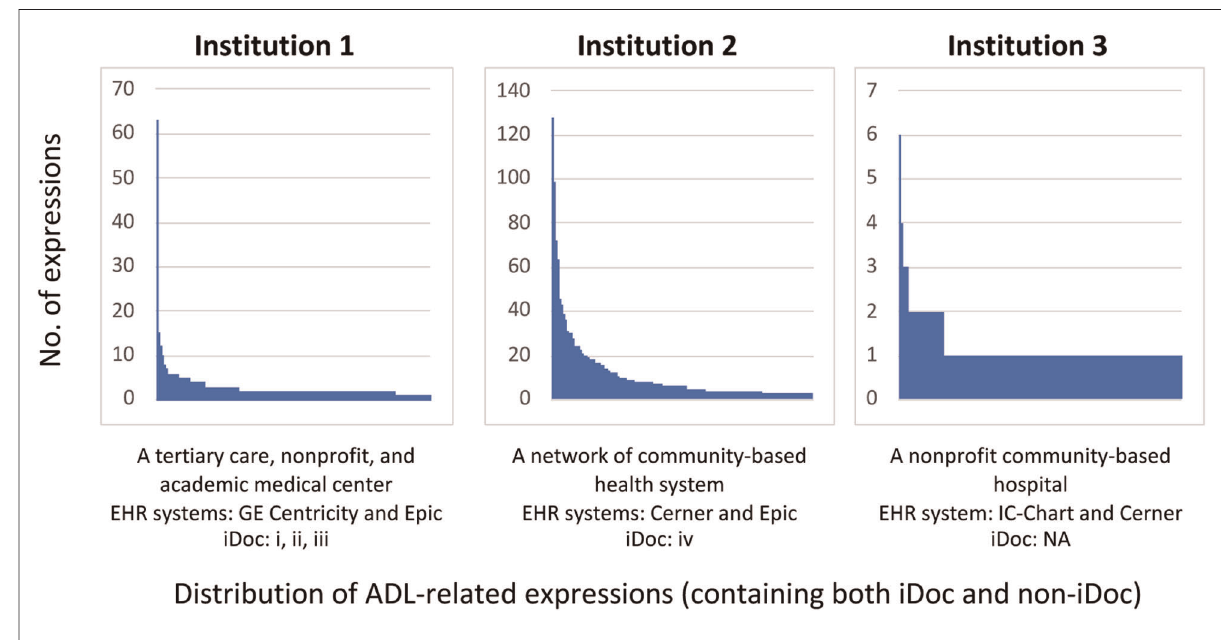
FIGURE 3 Distribution of ADL expressions in EHR documents across different institutions from the sampled annotation